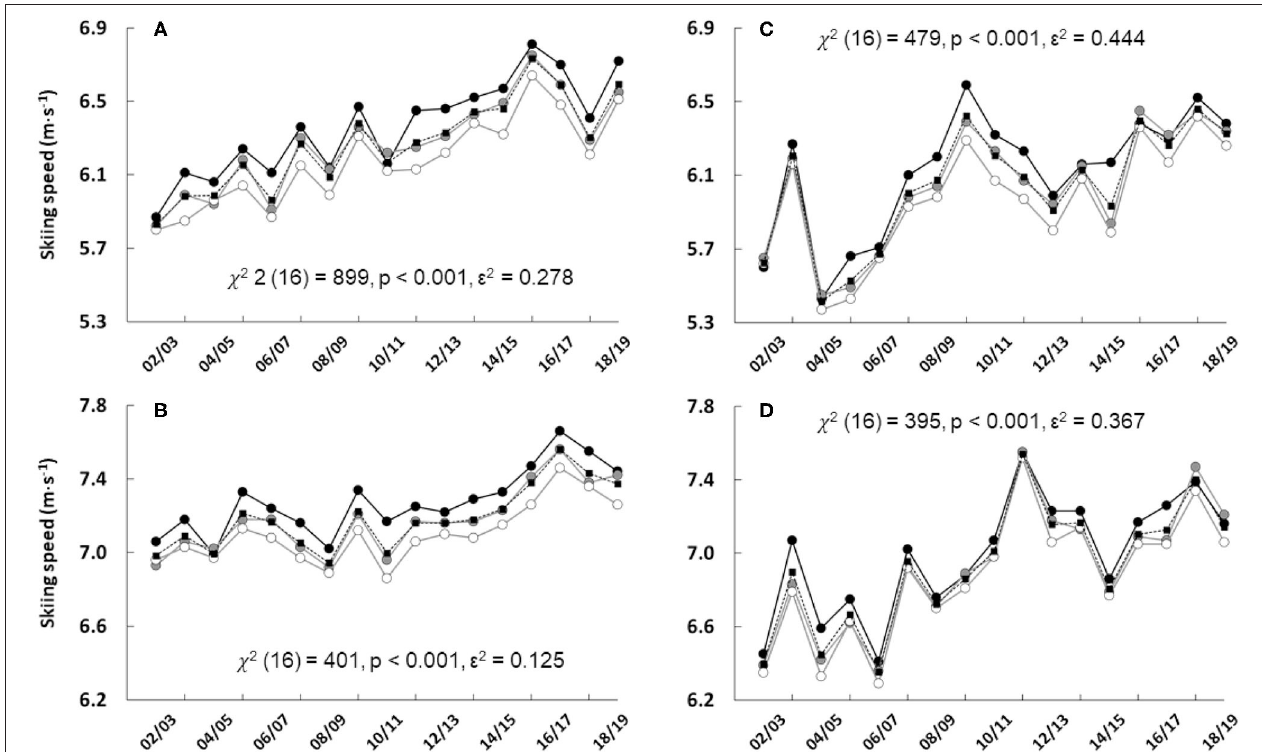
FIGURE 1 | The skiing speed in sprint and individual competitions for women [ (A) and (C) , respectively] and men [ (B) and (D) , respectively] including the overall (black dashes line, black squares) and groups of ranks 1–3 (black solid line, black filled circles), ranks 4–10 (gray solid line, gray filled circles), and ranks 11–20 (gray solid line, white filled circles) during seasons from 2002/2003 to 2018/2019. Each data point represents the median of all competitions during each season for each group. Sprint (A,B) and individual (C,D) include 9–10 and 3–4 competitions during each season, respectively, except season 2018/2019 having only 2 individual competitions.